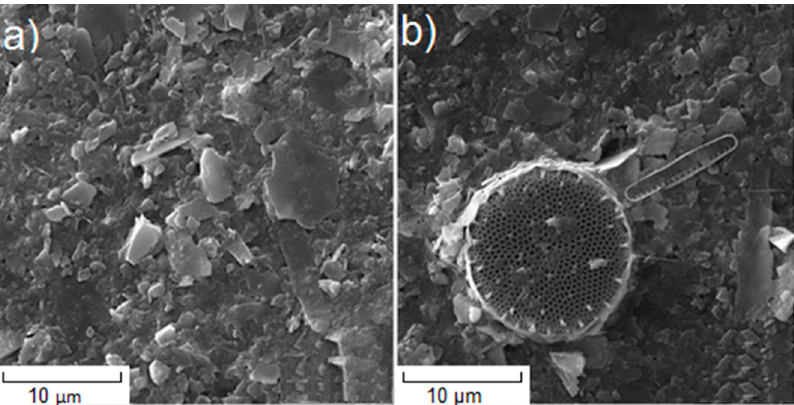
Figure 12. The composition of SPM in the fjord area of Prude Bay: ( a ) Nella (mainly mineral particles) and ( b ) Sunny (mainly nutrient particles) Fiords. Table 2. The concentration of SPM and OCs in the fast snow-ice cover.